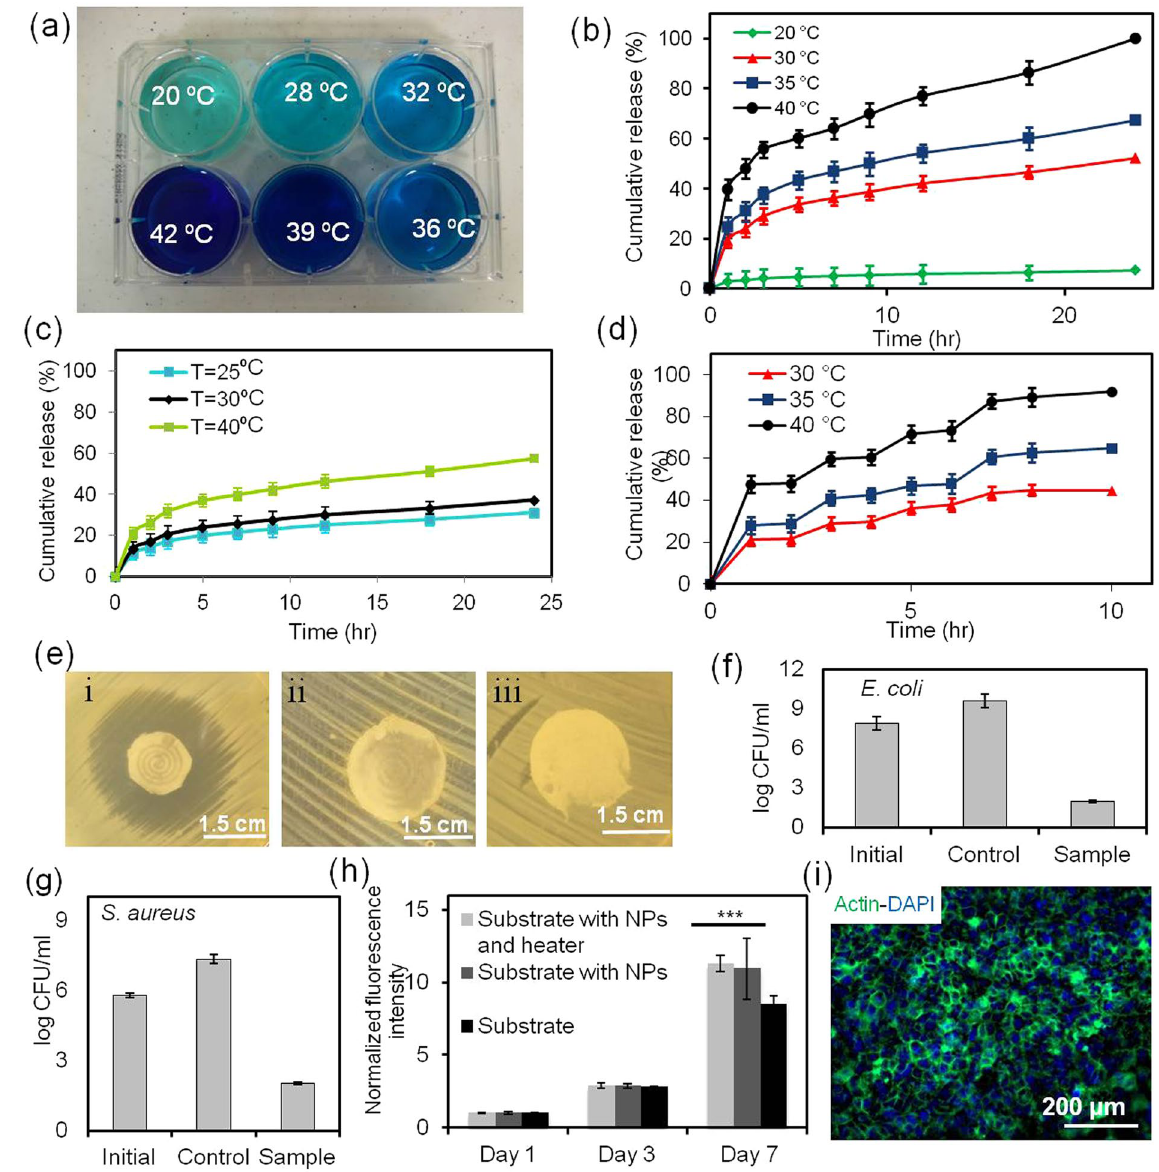
Figure 4. Characterization of the release profile and biocompatibility of the engineered platform. ( a ) Effect of temperature on the intensity of the methylene blue release from the nanofibrous platform. ( b ) The spectrum of release rate of cefazolin from the nanofibrous drug delivery system at different temperatures. ( c ) Effect of temperature on the interfacial release rate of ceftriaxone from the nanofibrous drug delivery system. ( d ) Cyclic thermal stimulation at different temperatures for on-demand release of cefazolin. ( e ) Assessment of the effectiveness of the released drug against bacterial culture; occurrence of a clear inhibition zone around the mesh containing cefazolin at 38 °C (i) in comparison to the mesh without cefazolin (ii) and the mesh containing cefazolin without heater after 12 h (iii). ( f , g ) Effect of the released antibiotics on the number of CFUs in a bacteria solution after 24 h of culture; ceftriaxone against E. coli and cefazoline against S. areus . ( h ) Metabolic activity of human keratinocytes cultured in contact with the nanofibrous substrate with and without nanoparticles and the flexible heater ( *** p < 0.001). ( i ) Immunostaining against F-actin and cell nuclei (DAPI) confirming the normal morphology of the cells cultured in contact with the nanofibrous